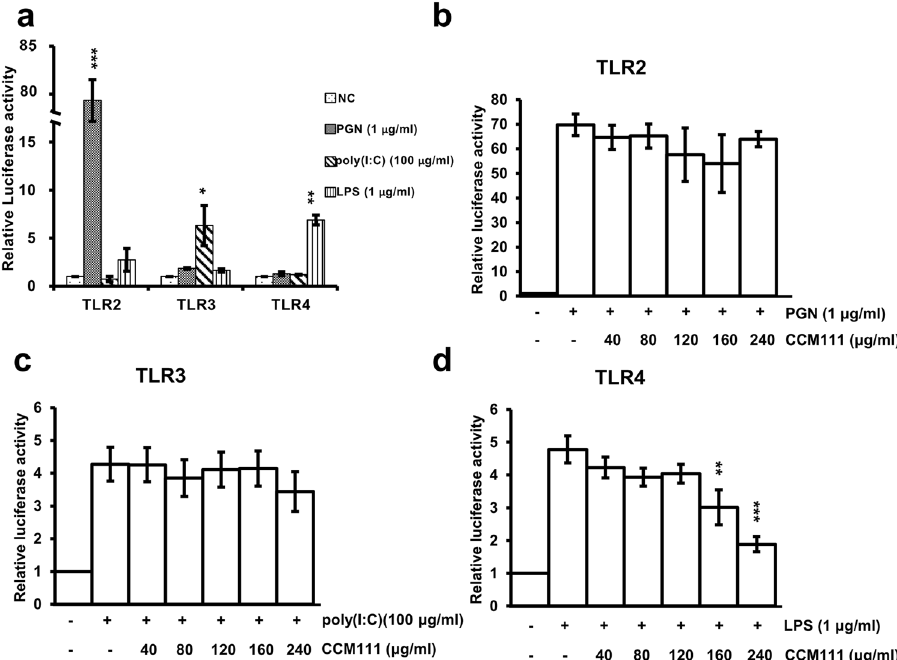
Figure 4. The effects of CCM111 on TLR signaling pathways. Three stable cell lines separately expressing TLR2-, TLR3- or TLR4-dependent luciferase reporters were separately treated with LPS (1 μ g/ml), PGN (1 μ g/ ml), and poly(I:C) (100 μ g/ml) for 17 hours as shown in ( a ). TLR2, TLR3 and TLR4 were constructed in the HEK293 cell line. Cells were treated with individual ligands and different doses of CCM111 as shown in ( b – d ). After 17 hours, the luciferase activity was measured. The S.D. was performed by Student’s t -test compared to the individual ligand group. ** p -value < 0.01 and *** p -value < 0.001. Results were obtained from three independent